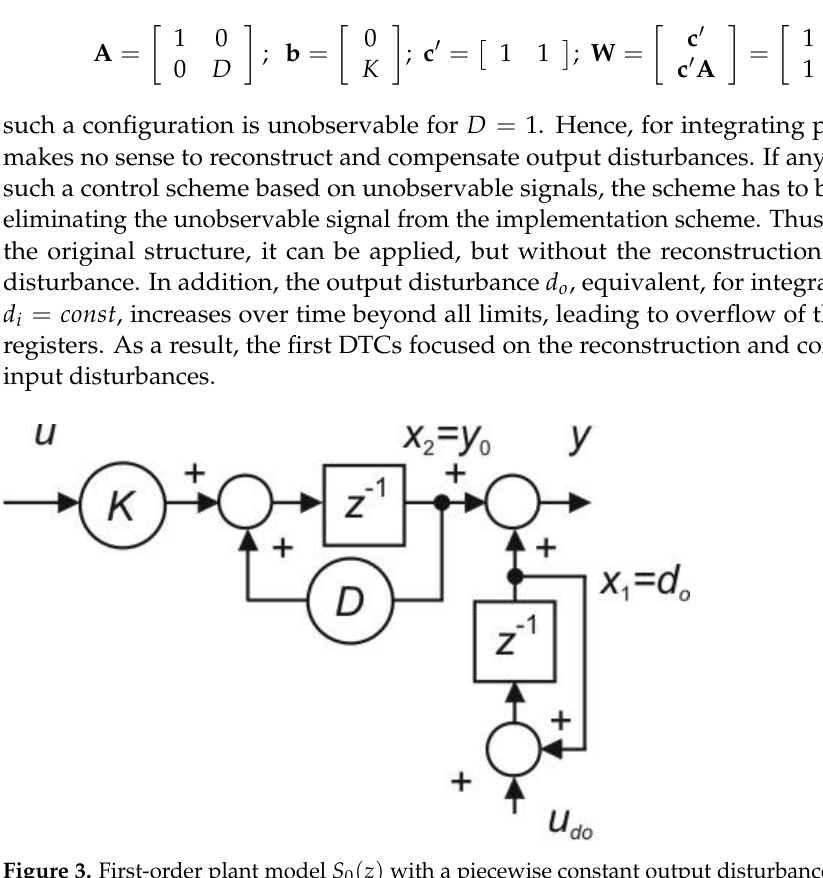
Figure 3. First-order plant model S 0 ( z ) with a piecewise constant output disturbance d o (changed by uncontrolled input pulses u do (cid:54) =